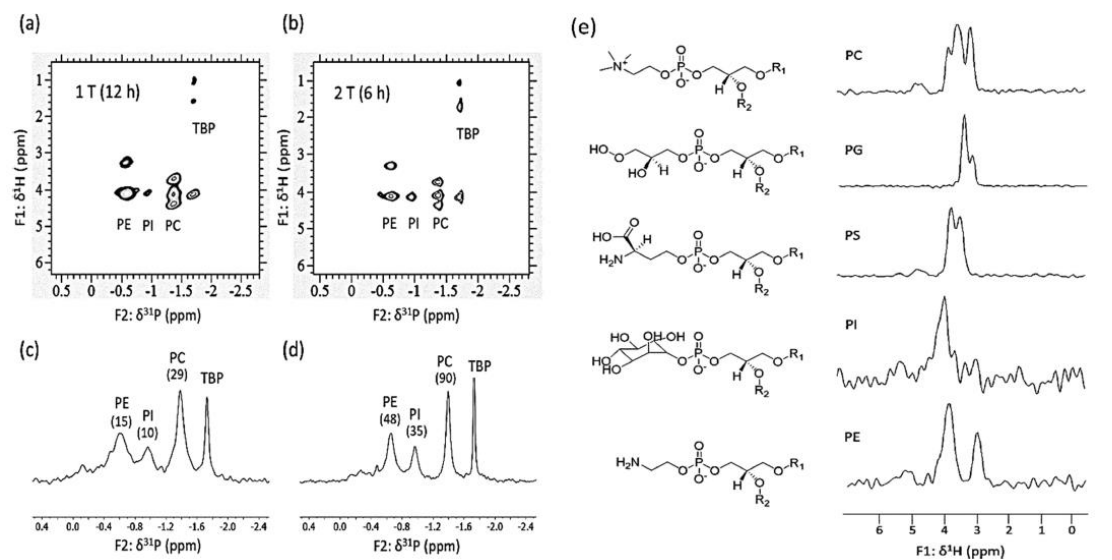
Figure 13. Application of benchtop NMR spectroscopy to phospholipid (lecithin) analysis using 2D 1 H- 31 P TOCSY at ( a ) 1 T, ( b ) 2 T; 31 P{ 1 H} spectra recorded at ( c ) 1 T and ( d ) 2 T. ( e ) 1 H traces obtained at 1 T. Adapted with permission from [124], ACS, 2019.